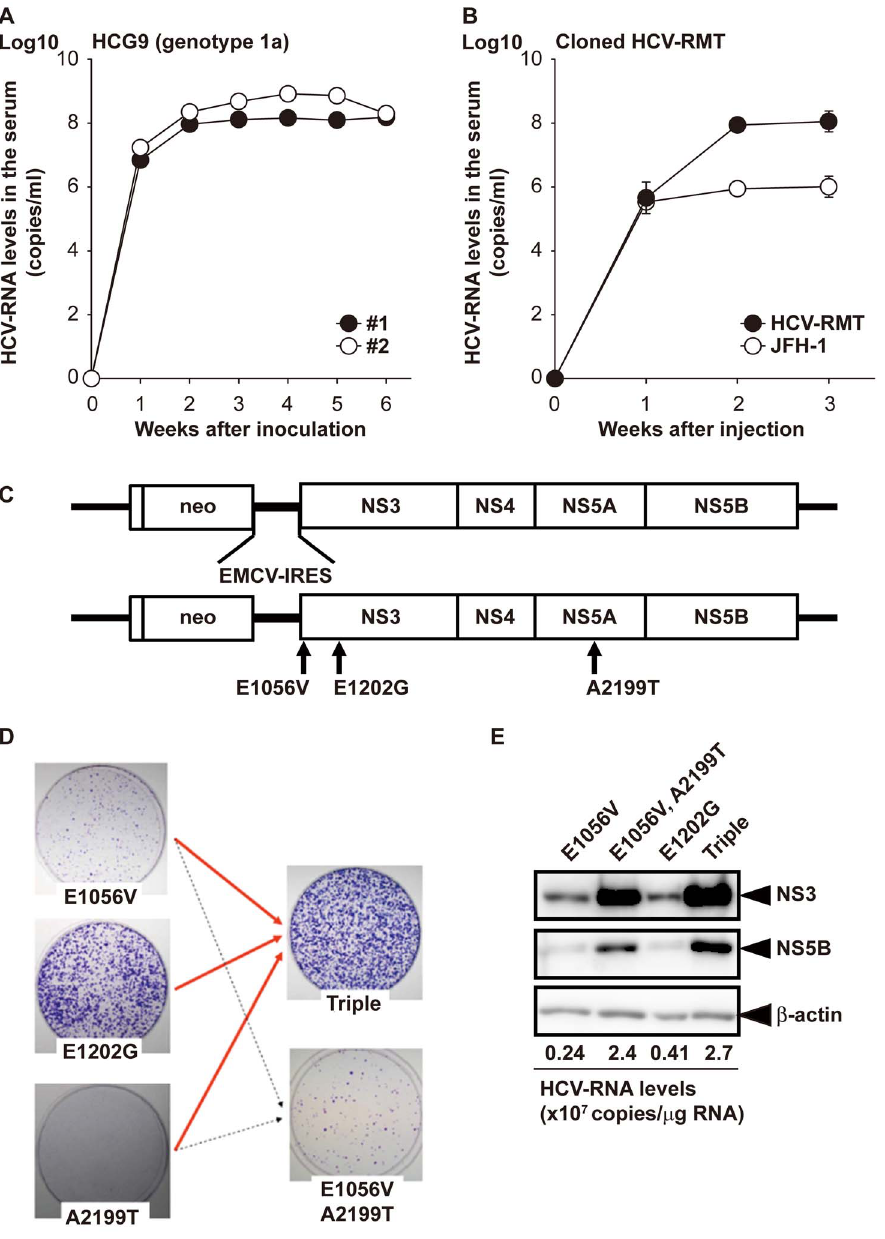
Figure 1. Basic characteristics of the HCV-RMT clone. Change in HCV copy number in chimeric mice. (A) Two mice were intravenously infected with 10 m l patient serum HCG9. (B) Three mice per group were directly injected with 30 m g HCV RNAs of the HCV-RMT strain or the JFH-1 strain into the liver. Data are indicated as the mean 6 S.D. (C) Schematic representation of construction of the replicon and the sites of adaptive mutations. (D) Colony formation assay of replicon clones with adaptive mutations. Each RNA (1 m g) was electroporated into HuH7-K4 cells. (E) Western blot analysis of replicon cells. Each culture of replicon RNA-electroporated cells was maintained and passaged with G418 selection for 2 weeks. Cell lysates (10 m g) were loaded onto an SDS-PAGE